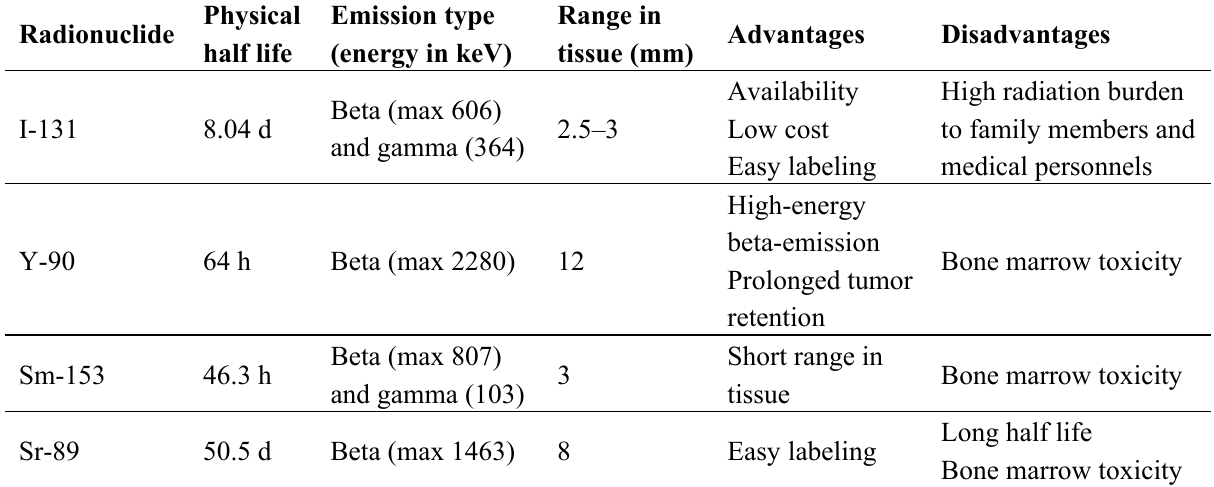
Table 1. Most commonly used radionuclides for targeted radiotherapy in US [4,5].